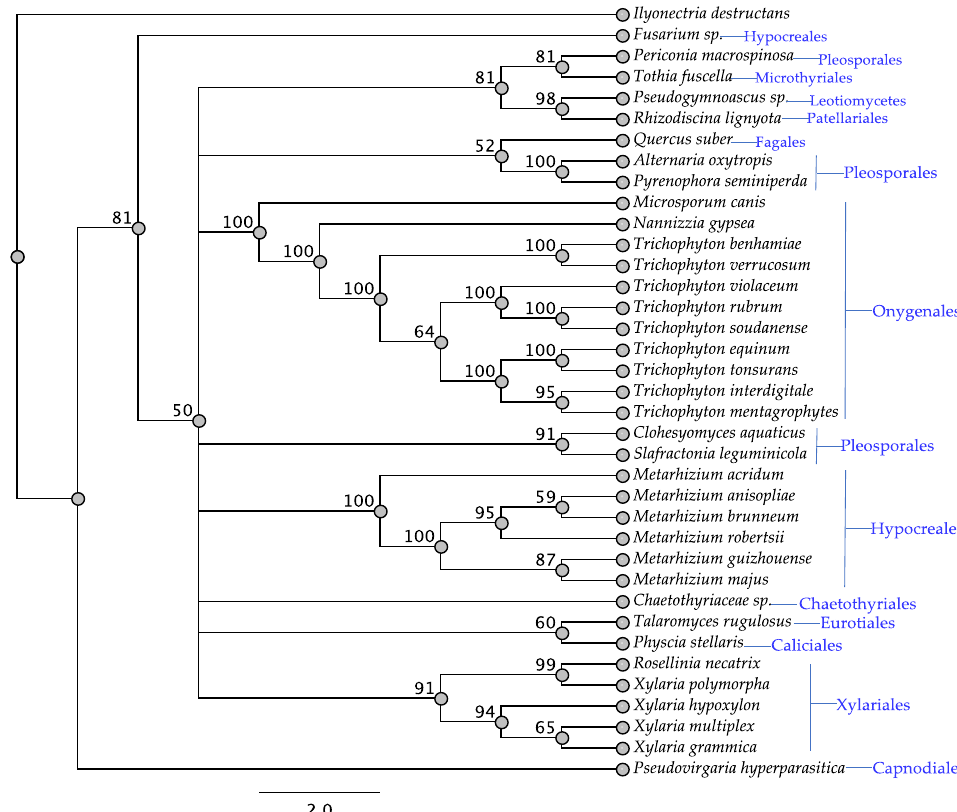
Figure 1. Maximum parsimony protein tree resulting from the analysis of SwnK. Bootstrap confidence values from 1000 bootstrap replicates are presented at each corresponding node. Ilyonectria destructans (Hypocreales) was used as the outgroup and obtained from NCBI database, GenBank accession: KAH7007558.1. Fungal orders are indicated next to each organism/clade.